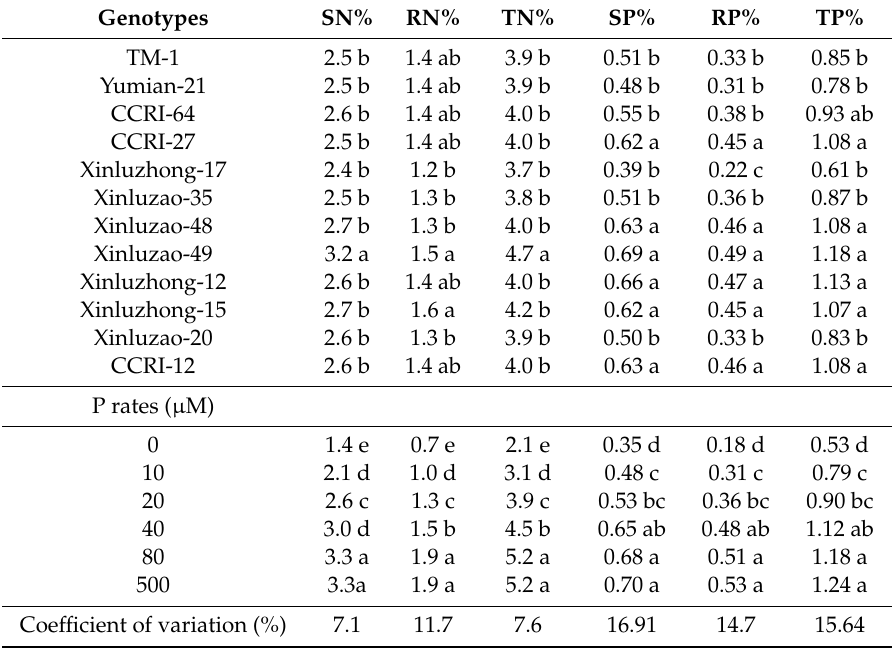
Table 5. Shoot nitrogen (SN%), root nitrogen (RN%), total nitrogen (TN%), shoot phosphorus (SP%), root phosphorus (RP%), and total phosphorus (TP%) of 12 cotton genotypes grown at di ff erent P concentrations in hydroponic